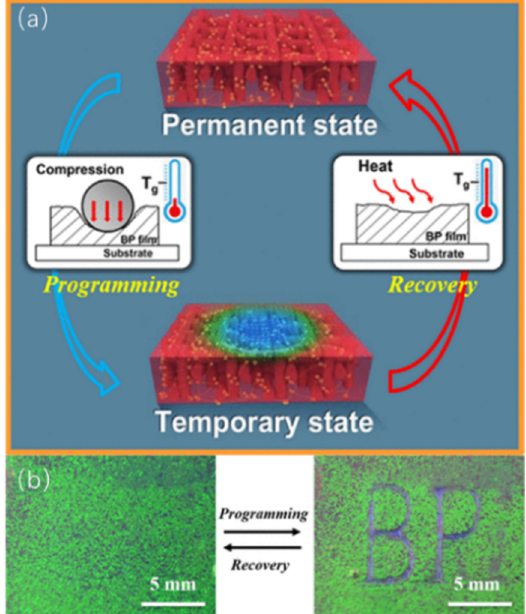
Figure 9. ( a ) Schematic diagram of the shape-memory process; ( b ) Writing and erasing of the BP pattern [90] . Photonic Shape Memory Polymer Based on Liquid Crystalline Blue Phase Films from Yang, Appl Mater Interfaces, published by American Chemical Society.